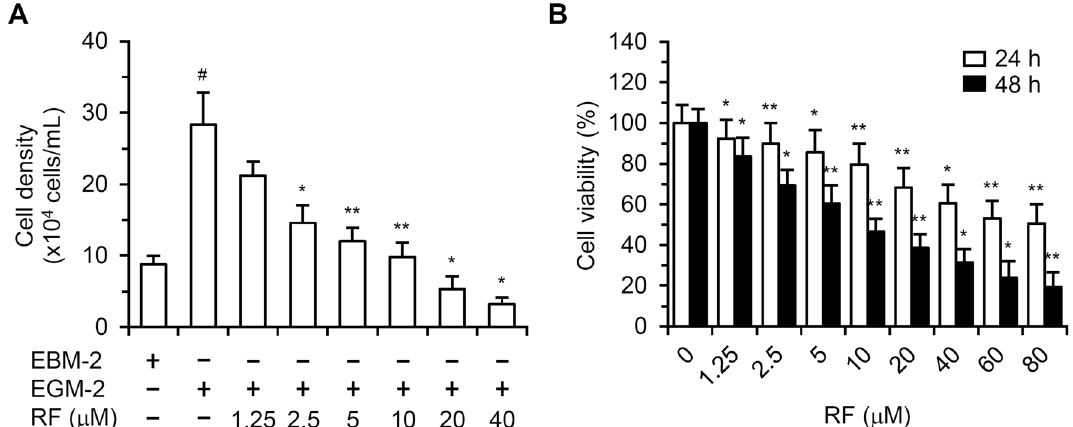
Figure 1. Analysis of HUVEC proliferation and RF cytotoxicity. ( A ) HUVECs were incubated for 48 h with EGM-2 containing different RF concentrations. The cells were trypsinized, stained with trypan blue, and counted using a hemocytometer. The cell density data are shown in the bar graph. The data are presented as the mean ± SD of three independent experiments; # p < 0.05, compared to EBM-2-treated cells; * p < 0.05, ** p < 0.01, compared to EGM-2-treated cells. ( B ) HUVECs were incubated for 24 or 48 h with EBM-2 containing different RF concentrations, and cell viability was assessed with the MTT assay. The data are presented as the mean ± SD of three independent experiments; * p < 0.05, ** p < 0.01, compared to the